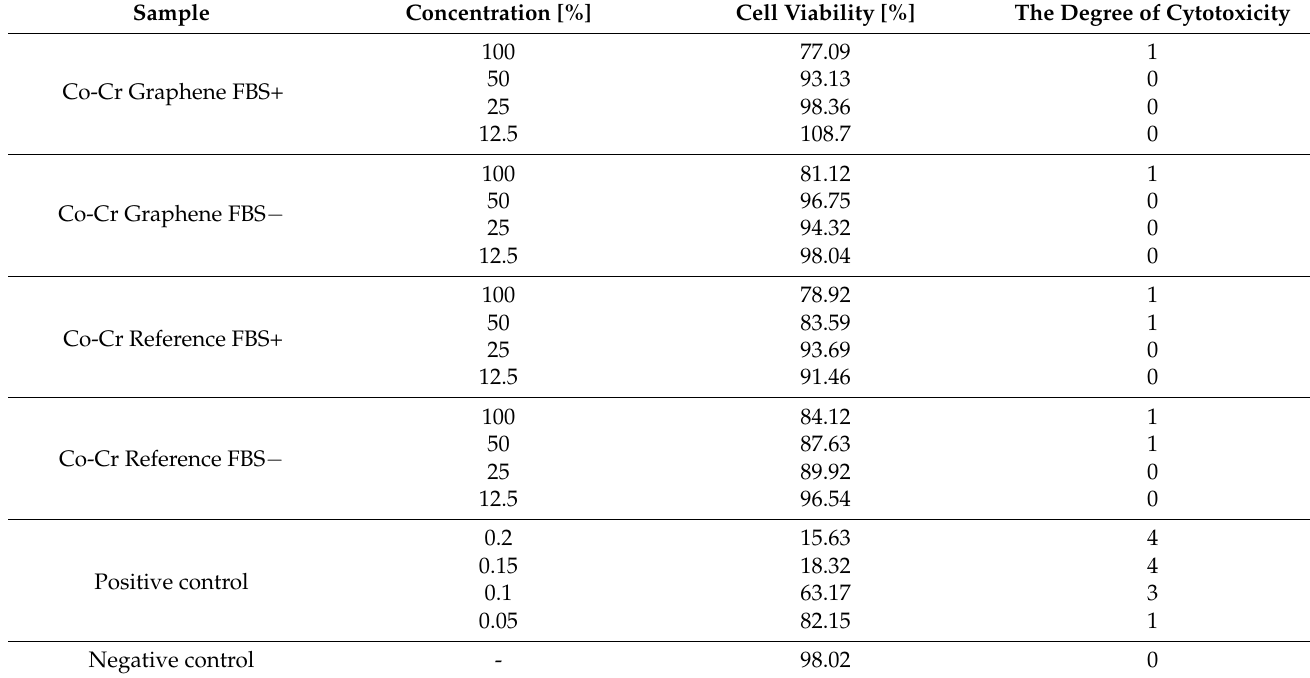
Table 3. Evaluation of the cytotoxicity of extracts from tested Co-Cr disks, extract preparation solutions, and experiment control.